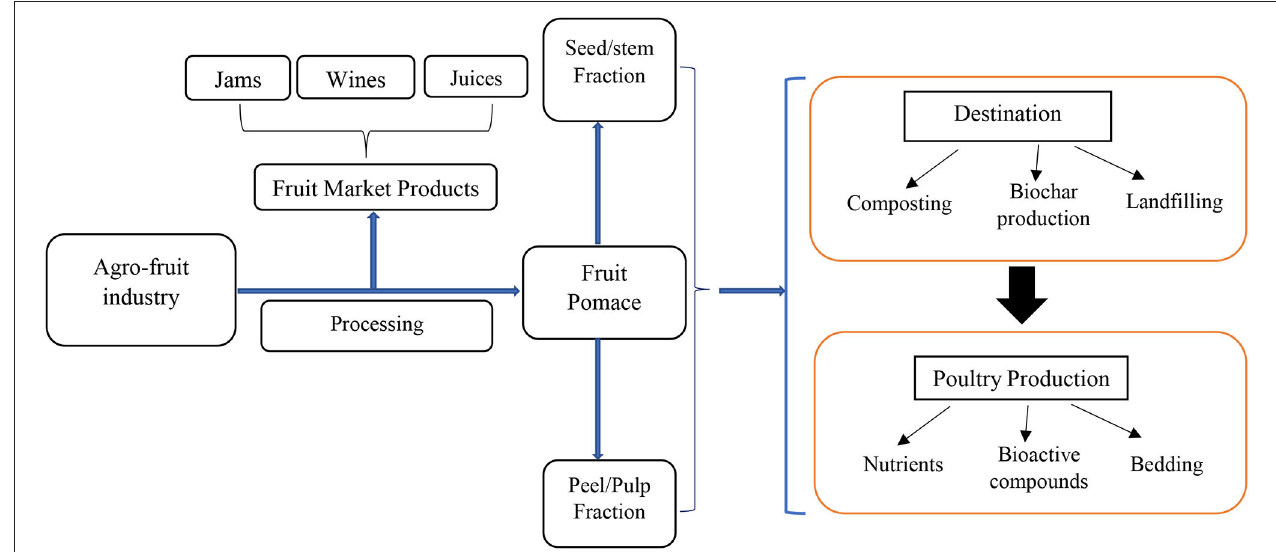
FIGURE 1 | Valorization of fruit pomace waste into value-added